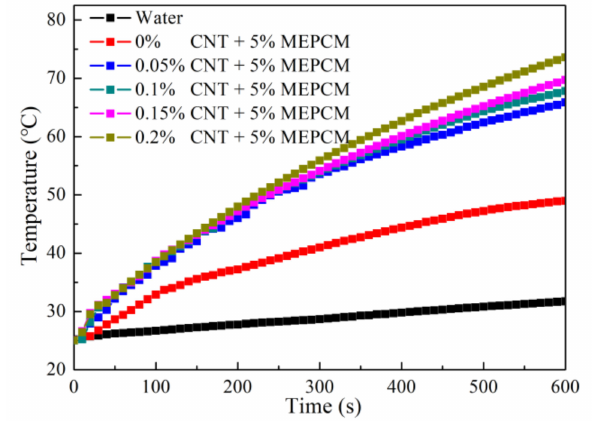
Figure 10. Temperature variation curves with irradiation time of water and hybrid